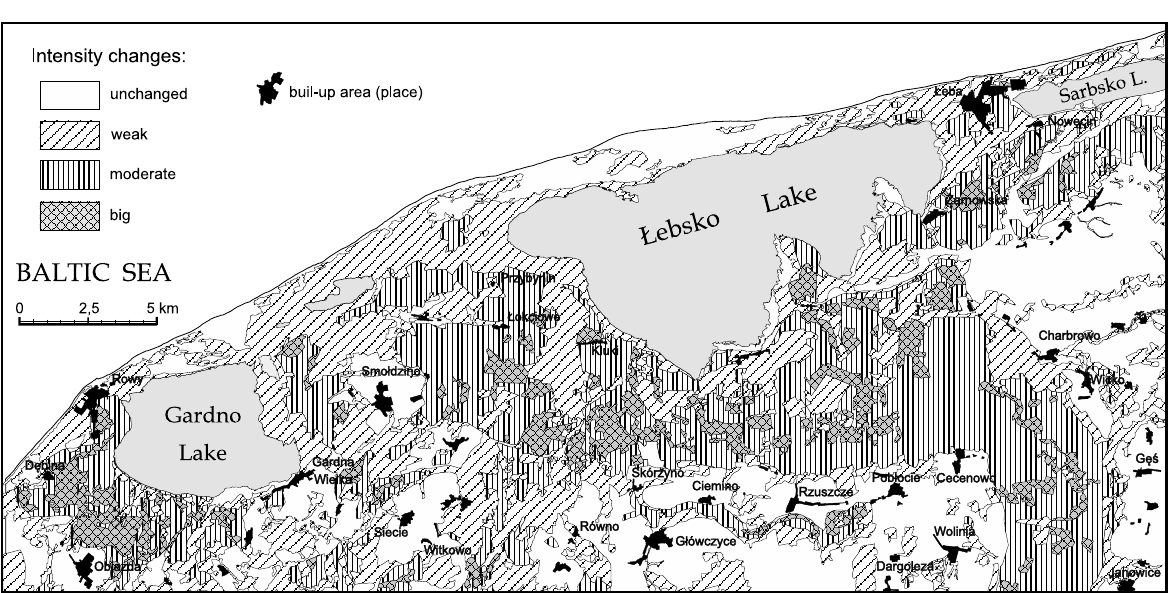
Fig. 11. Intensity of anthropogenic changes in water relationships of Gardno-Łeba Lowland in the period from the first half of the 19th c. to the end of 20th